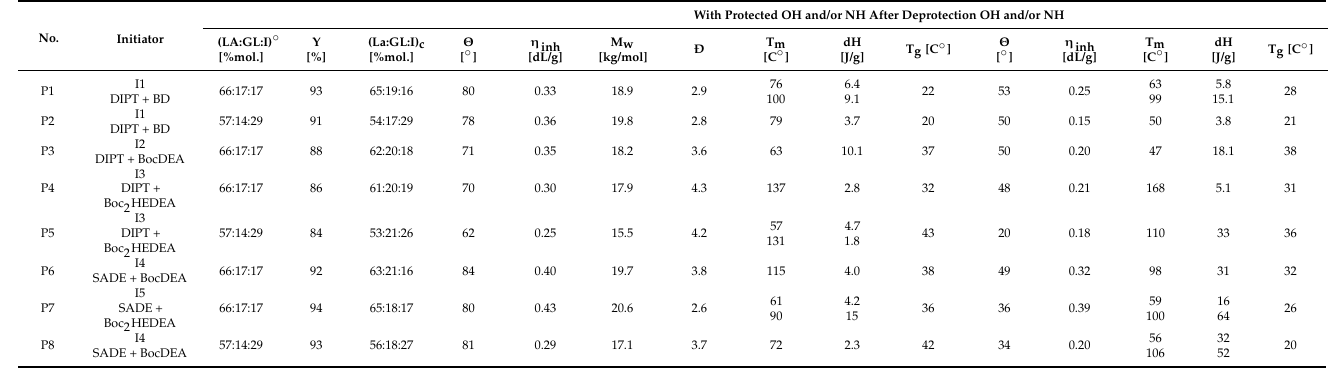
macro-initiator used by Table 1; (LA:GL:I) ◦ —starting composition of the reaction mixture (molar ratio of L-lactide/glycolide/macroinitiator); (LA:GL:I) c —terpolymer composition (molar ratio of lactidyl/glycolidyl units/macroinitiator derivative units); Y—yield; Θ —static contact angle; η inh —inherent viscosity; M w